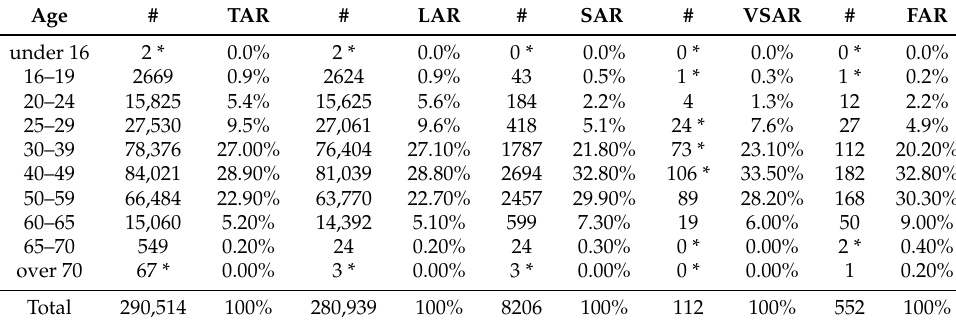
Table 4. Age of injuried.